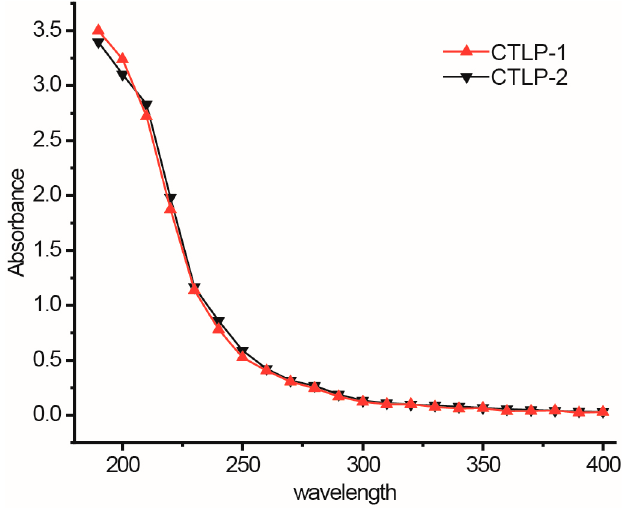
Figure 2. The UV spectrum of CTLP ‐ 1 and CTLP ‐